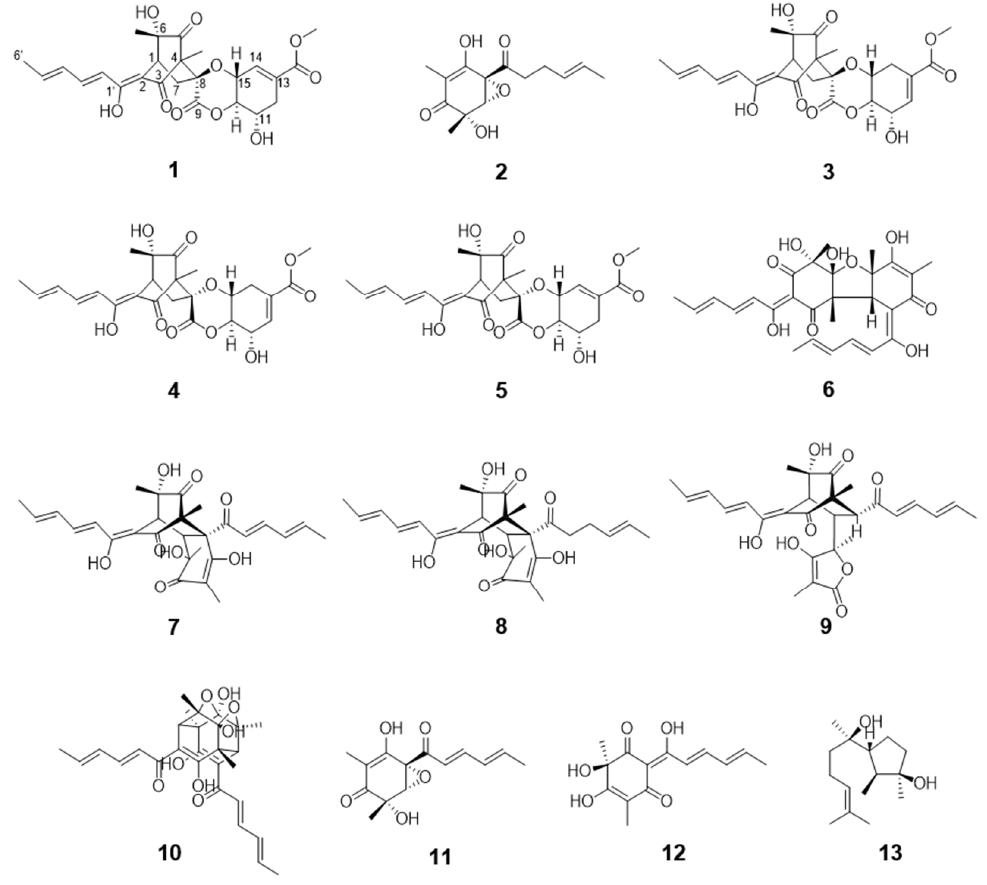
Figure 2. Chemical structures of compounds 1 – 13 isolated from the fungus Trichoderma longibrachiatum SFC100166.